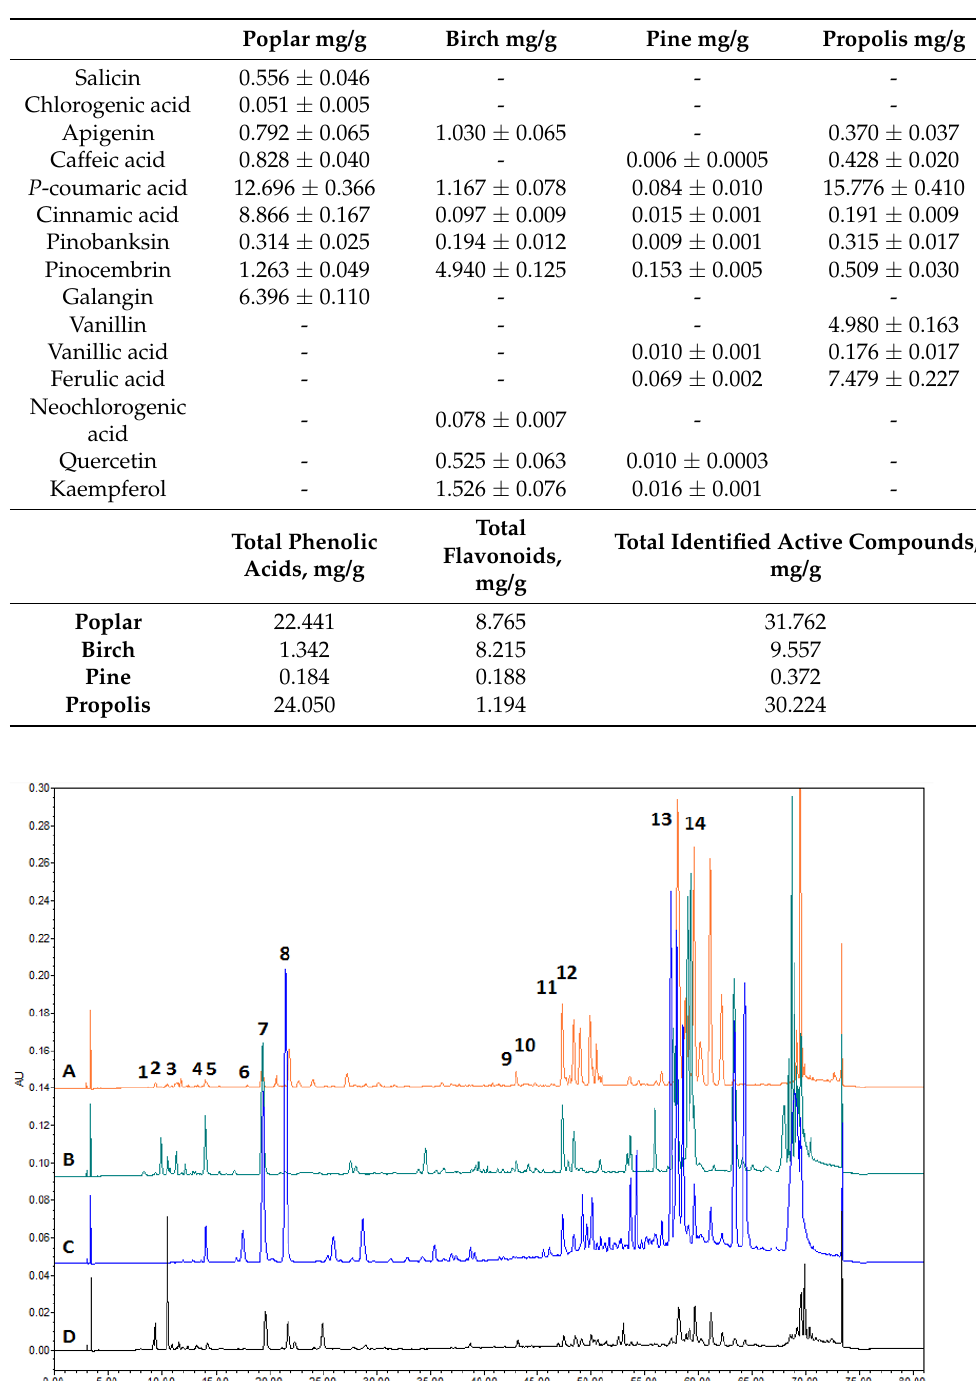
Table 2. HPLC analysis of ethanolic poplar, birch, pine buds and propolis extracts (mg/g). Results expressed as mean and standard deviation (SD) of three measurements.